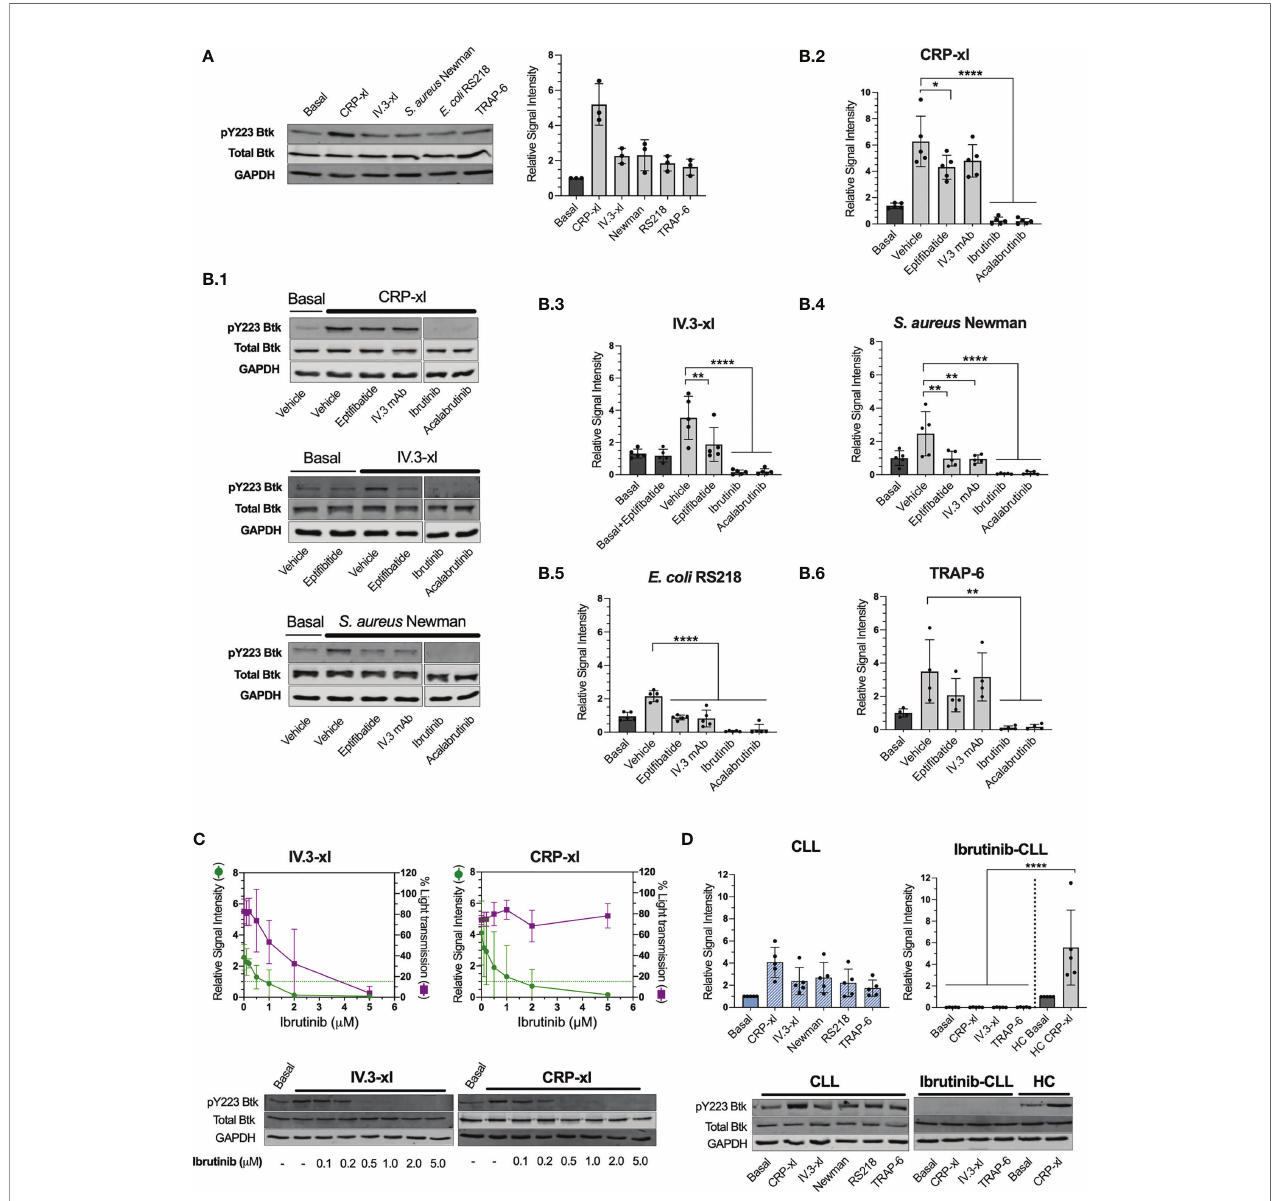
FIGURE 5 | Platelet stimulation by bacteria or crosslinked IV.3 mAb causes Btk activation in healthy donors and CLL patients that is inhibited by ibrutinib and acalabrutinib. Phosphorylation of Btk at Y223 was measured by immunoblotting in whole cell lysates collected from healthy control or CLL PRP aggregation reactions using the following agonists: 3 m g/ml CRP-xl, crosslinked IV.3 (IV.3-xl; 4 m g/ml mAb IV.3 followed by 30 m g/ml F(ab ’ )2 rabbit anti-mouse IgG), S. aureus Newman, E. coli RS218, and 3 m M TRAP-6. In some cases, platelet inhibitors were used as indicated below. All lysates were collected at 3 minutes after the start of aggregation, or a parallel time point in samples in which aggregation was inhibited. Lysates were adjusted to an equivalent of 5 x10 8 platelets/ml as explained in Materials and Methods. (A) Btk pY223 phosphorylation in healthy donor platelets stimulated with assorted agonists. Pooled data from three